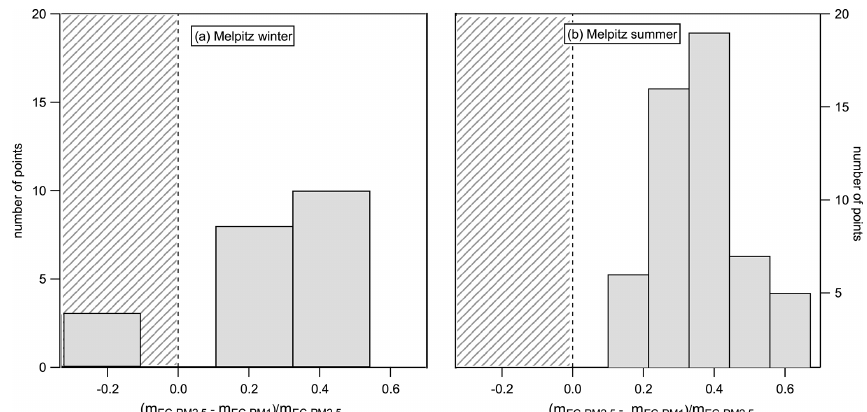
Figure 4. Histogram of ( m EC–PM2.5 − m EC–PM1 ) /m EC–PM2.5 for Melpitz winter ( a , on the left) and summer ( b , on the right) campaigns. The area with the oblique grey lines indicates the non-physical part in which m EC–PM2.5 <m EC–PM1 , reflecting the uncertainty in the EC